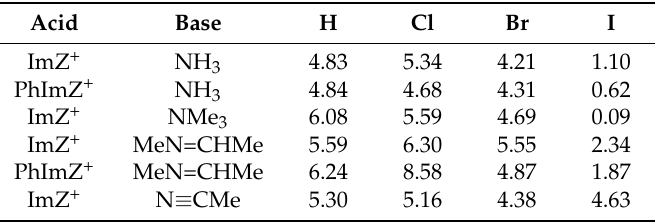
Table 4. Free energies (kcal/mol) of binding substituted imidazoliums with N-bases in CH 2 Cl 2 solvent at 298 K.